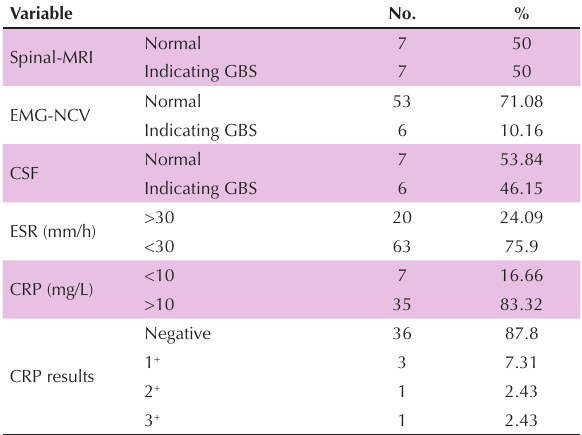
Table 3. Frequency distribution of paraclinical finding of the studied patients Variable No. % Spinal-MRI